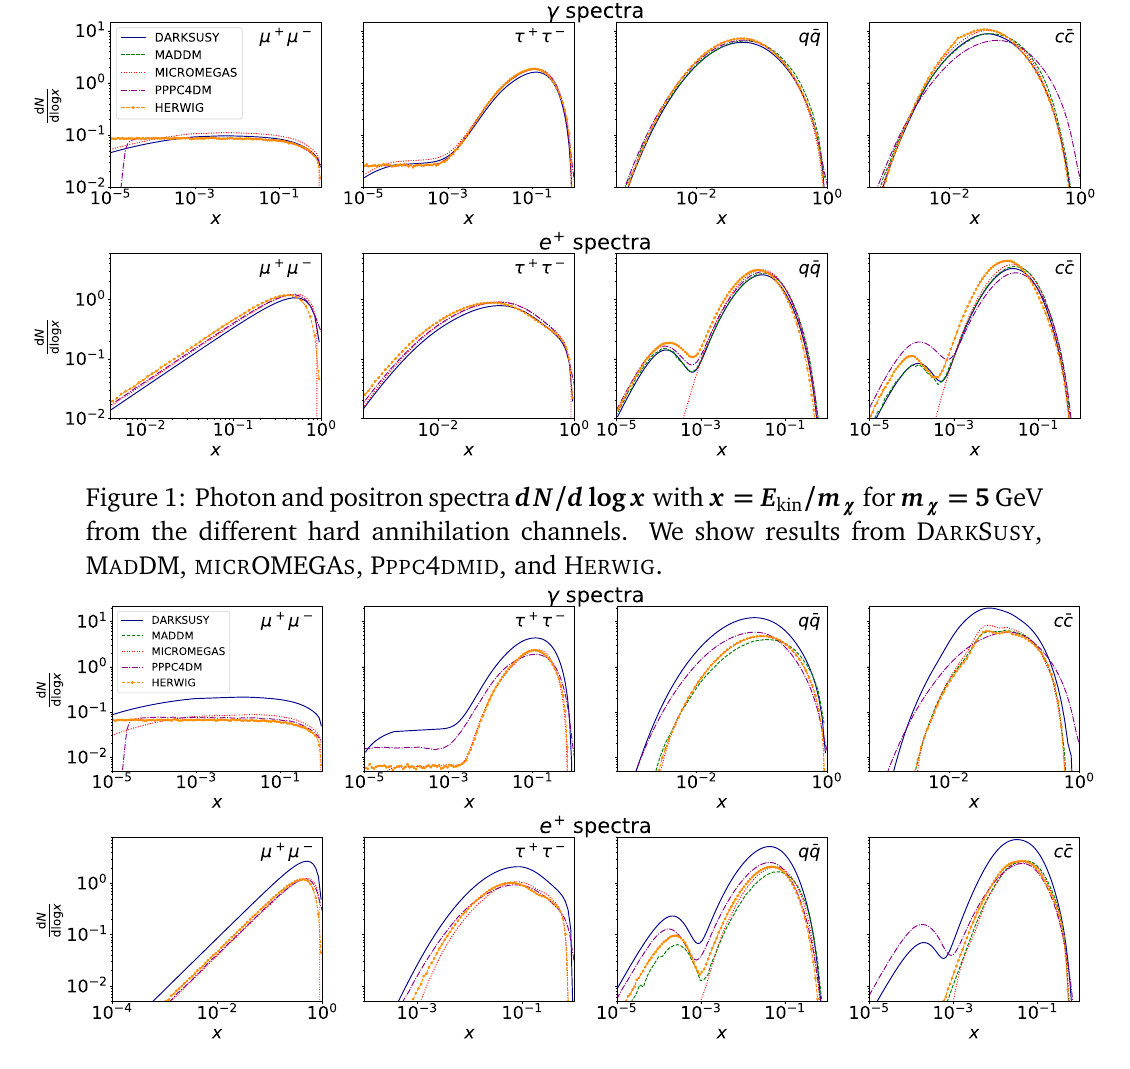
Figure 2: Photon and positron spectra dN / d log x with x = E from the different hard annihilation channels. We show results from D ARK S USY , M AD DM, MICR OMEGA S , P PPC 4 DMID , and H ERWIG . e + e − → SM pairs, at a given energy m